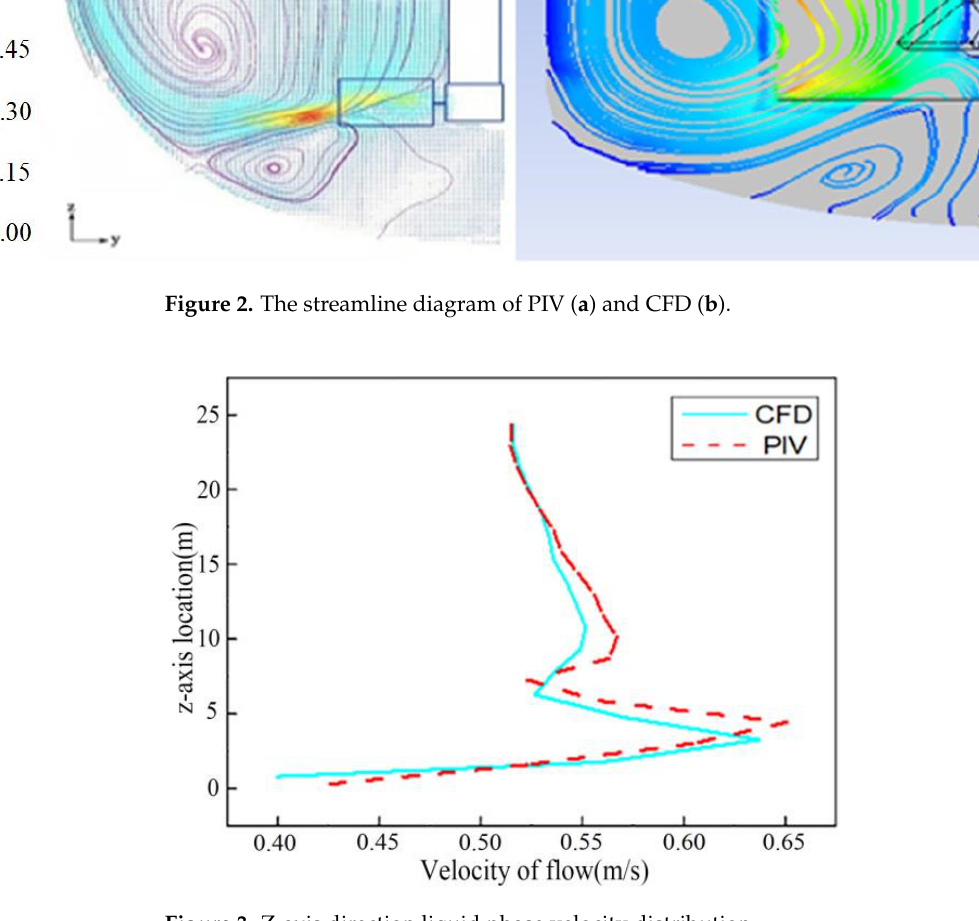
Figure 3. Z-axis direction liquid phase velocity distribution.